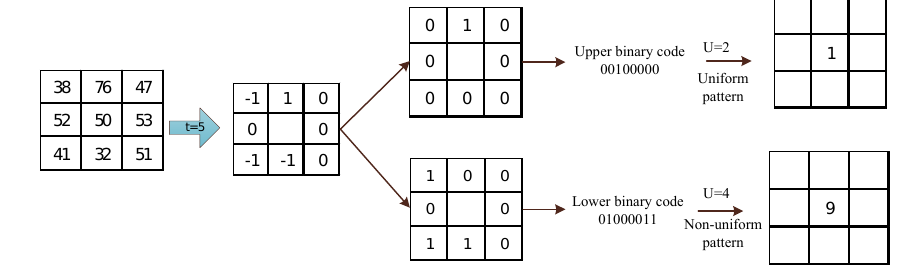
Figure 2. An example calculation of ILTP patterns for a given pixel when U